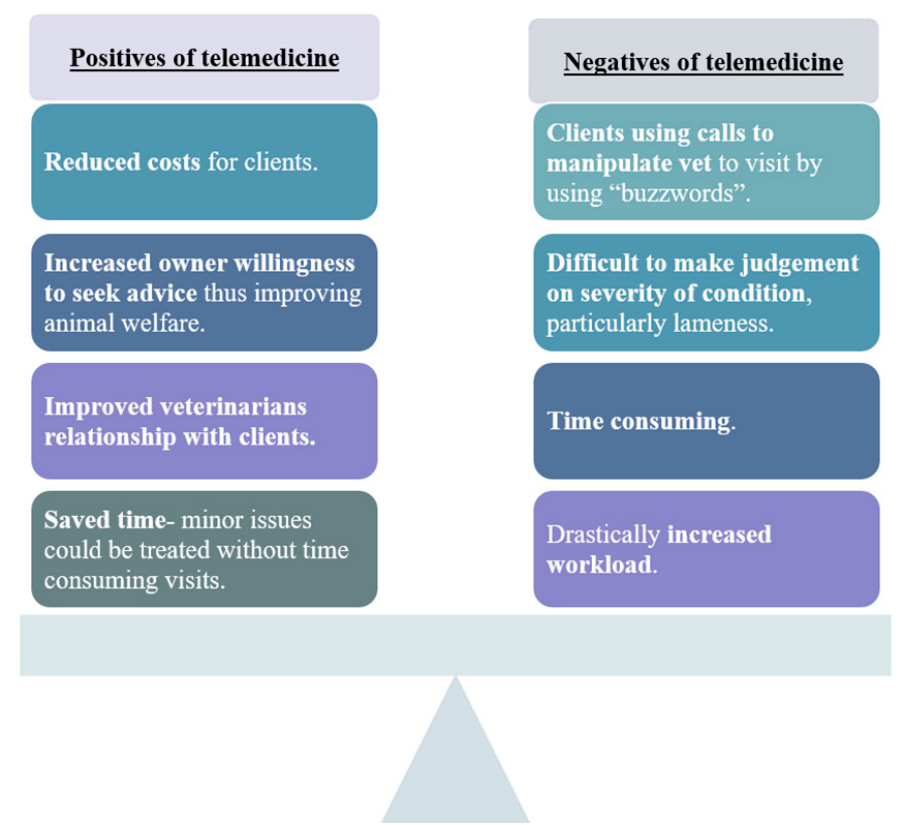
Figure 1. The positives and negatives of telemedicine for equine veterinary management. On balance, the positives and negatives of telemedicine for equine veterinary man- agement were largely equal. Figure 1 shows that reduced costs, improved relation-